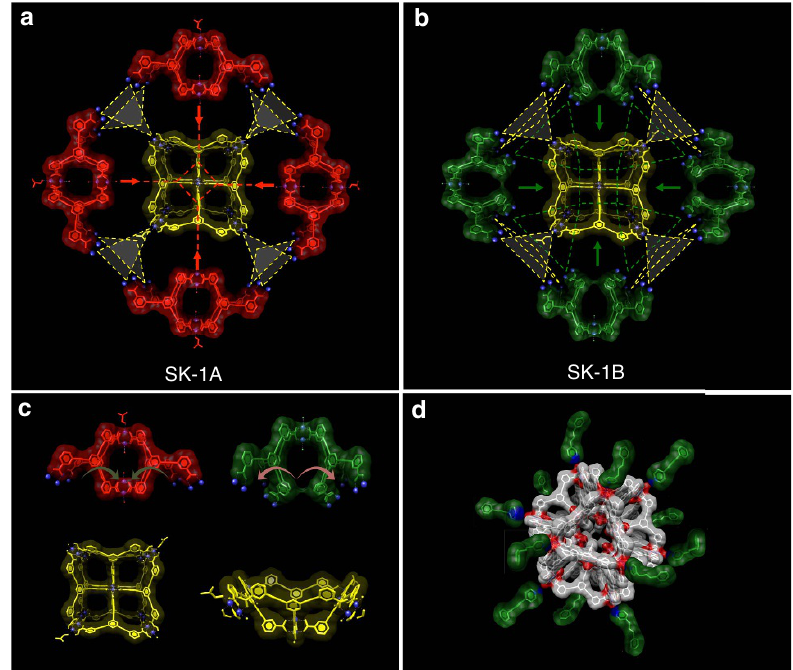
Figure 2 | Sub-cages and building units of SK-1. ( a , b ) Building principles of SK-1A and SK-1B. Intersected lines indicate fusion points. Yellow lines give rise to the formation of square faces of the cuboctahedron (yellow units in c ); Green and red lines indicate the position of the inner-located {Cu 2 } units that form part of the inner octahedron. In SK-1A only two {Cu 2 } units locate below square face (yellow units in a ) leaving the remaining four faces open while in SK-1B all six inner {Cu 2 } units locate directly below square faces. ( c ) Structural motifs in SK-1A and SK-1B. Red: ‘Super-paddlewheel’ cage that results from a syn, syn -binding mode of two benzoate functionalities of the m -BTEB ligand and whose guest binding ability is significantly determined by the inter-(Cu 2 } distance in the inner cavity; approximately co-planar arrangement of benzoate rings. Green: Cage motif that results from a syn, anti -binding mode of two benzoate functionalities of the m -BTEB ligand; approx. perpendicular arrangement of one benzoate ring with respect to the other outer two benzoate rings of the m -BTEB ligand; Yellow: ‘Capping’ motif with square topology; one of the benzoate ligands of the m -BTEB moieties adopts an approximate perpendicular arrangement with respect to the other two benzoate rings. ( d ) Schematic representation of the possible functionalization using 4-(3-phenylpropyl)pyridine